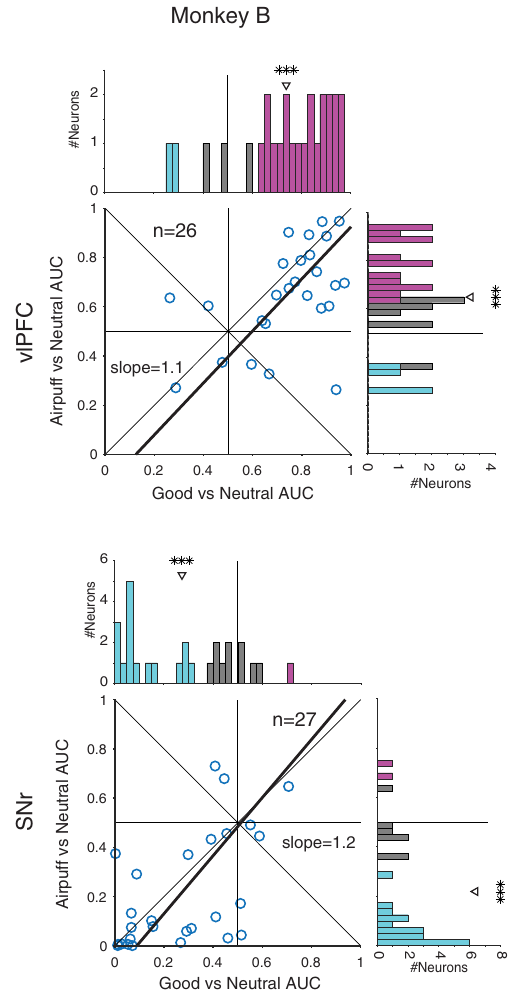
Fig. 3 | Positive correlation between aversive and value signals in vlPFC and cdlSNr for airpuffassociated objects which had positive salience. Marginal and joist distribution of aversive AUC (>0.5: airpuff > neutral) vs value (>0.5: good > neutral) AUC across all neurons in vlPFC (top row) and in cdlSNr (bottom) sepa- rately for each monkey. (Monkey B, vlPFC Pearson ’ s ρ =0.48, P =1e-2, value AUC=0.73, t 25 =6.1, P =1e-6, aversive AUC=0.65, t 25 =3.7, P =9e-4, cdlSNr: